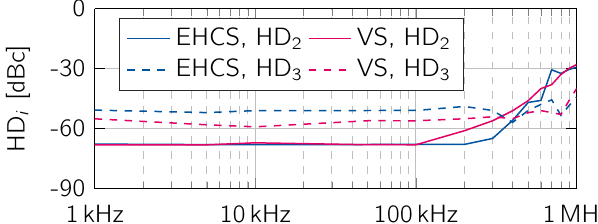
Figure 15: The second harmonic distortions (solid lines) increase above 100 kHz up to approx. -30 dBc for both